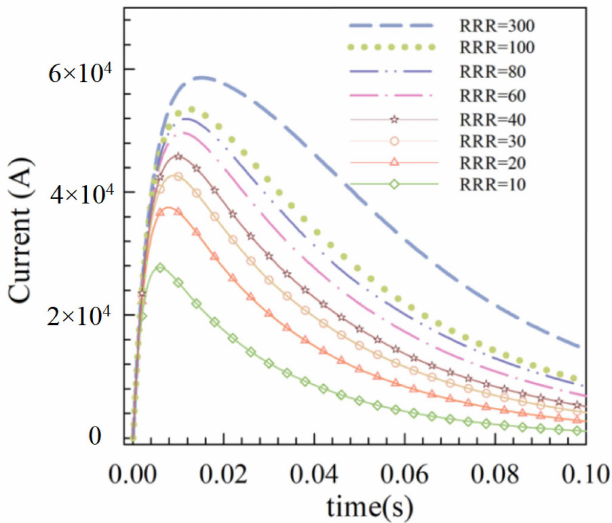
Figure 11. Current in different copper discs during fast discharging tests.